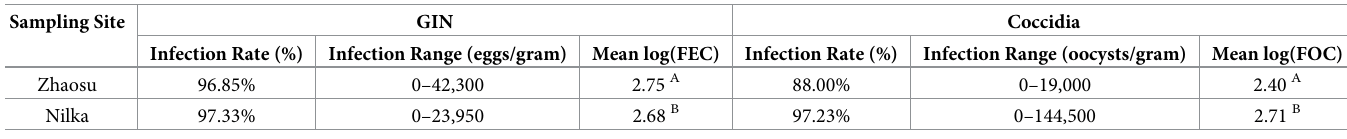
Table 2. Sheep GIN and coccidia infection in different regions. Sampling